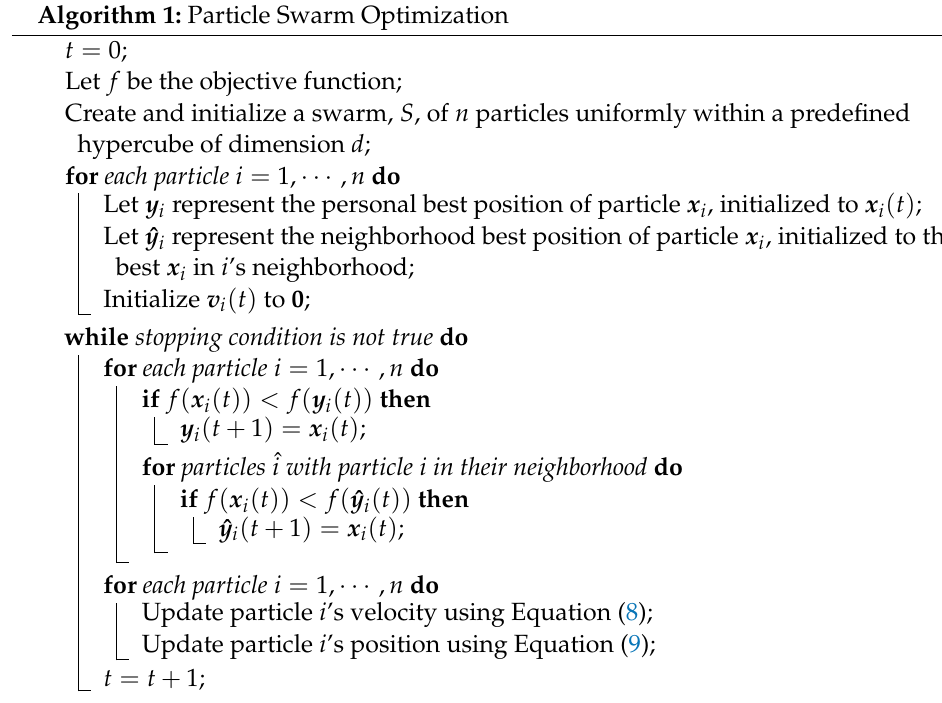
Algorithm 1: Particle Swarm